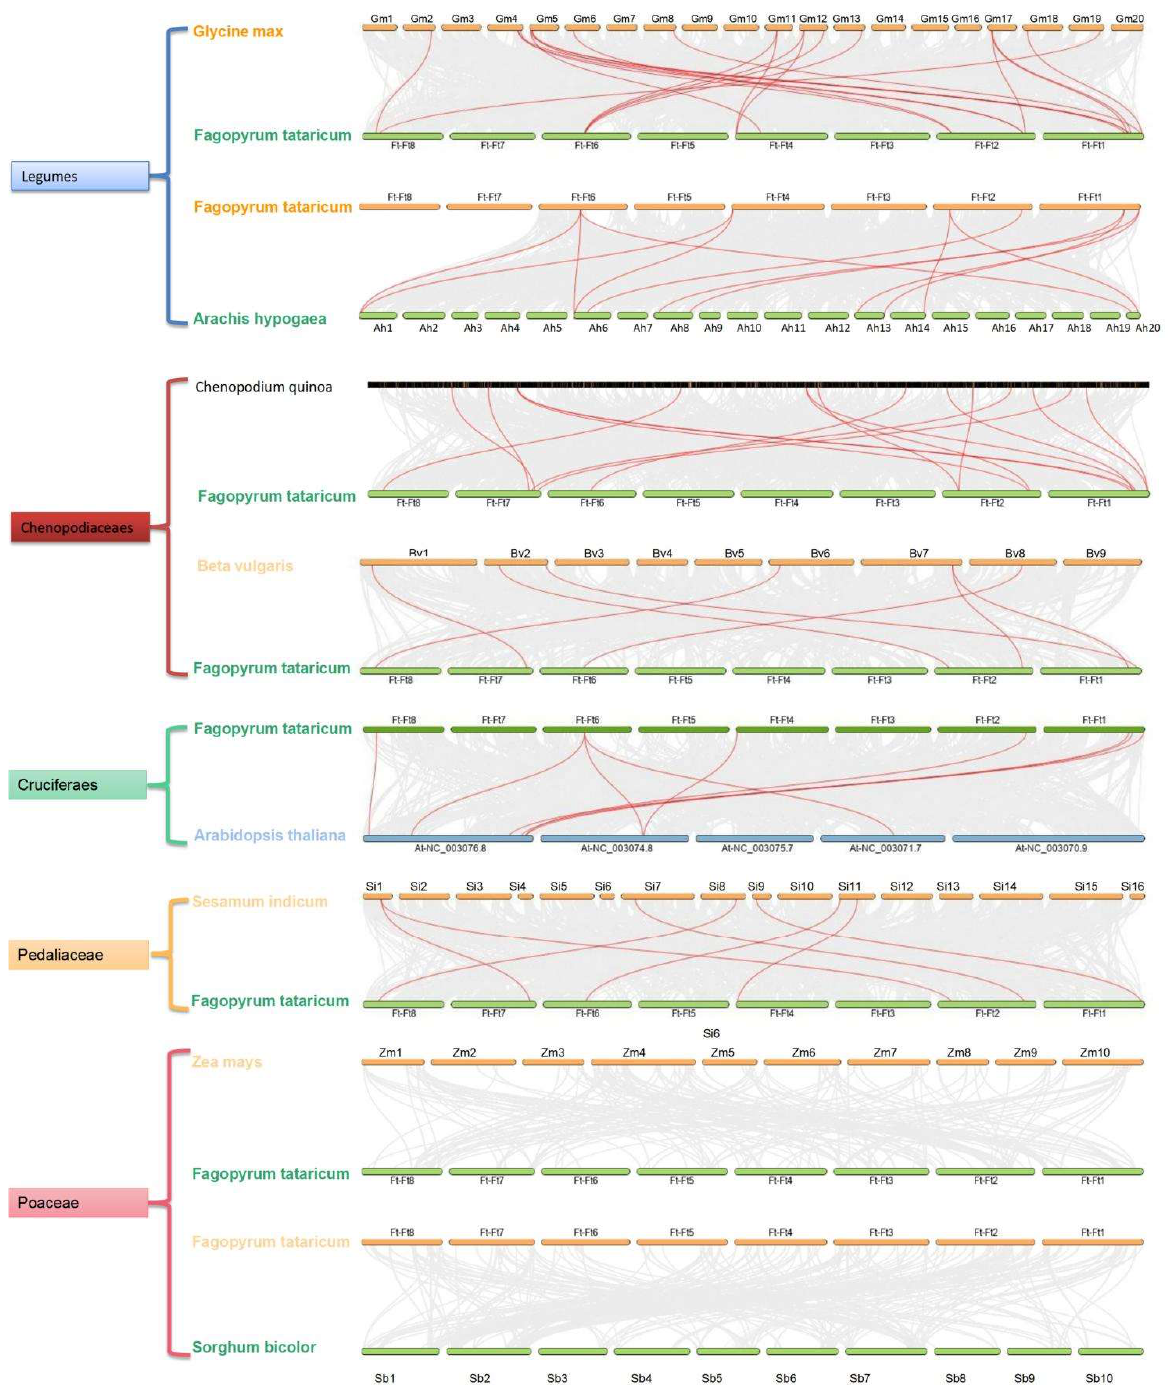
Figure 4. Synteny analyses of HDACs between Fagopyrum tataricum and other five representative plant species. Gray lines in the background indicate the collinear blocks within Fagopyrum tataricum and other plant genomes, while red lines highlight the syntenic HDACs gene pairs.